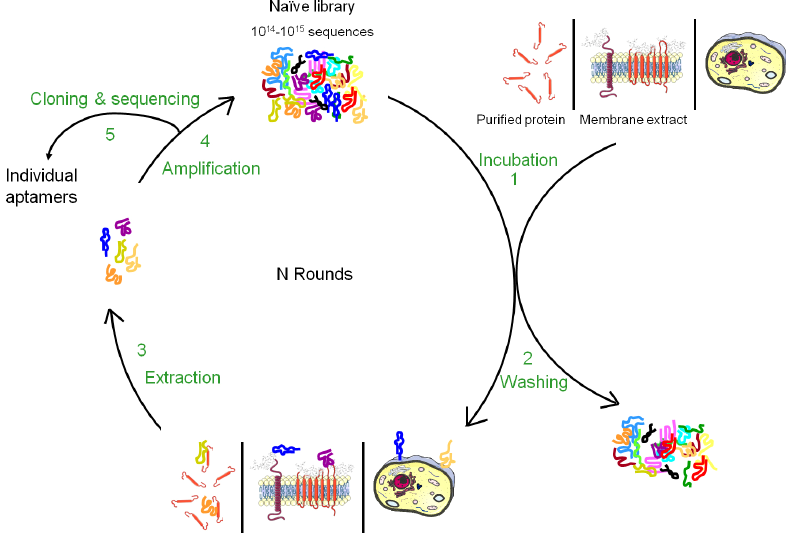
Fig. 5. The general principle of the SELEX procedure for a cell surface biomarker. (1) Oligonucleotide-based library is incubated with a target (puri¯ed cell surface biomarker, membrane extract or whole living cell or organism). (2) Using di®erent partitioning methods (i.e., a±nity chromatography, ¯ltration, centrifugation) to remove unbound sequences. (3) Bound sequences are eluted (i.e., urea, EDTA, competition with a ligand). (4) Ampli¯cation by PCR (or RT-PCR and in vitro transcription in the case of RNA libraries). The selected pool then enters a new cycle of selection, repeating rounds of selection to evolve the population of the sequences. (5) Finally, sequences are cloned and sequenced to identify the aptamers. Adapted with permission from Ref.